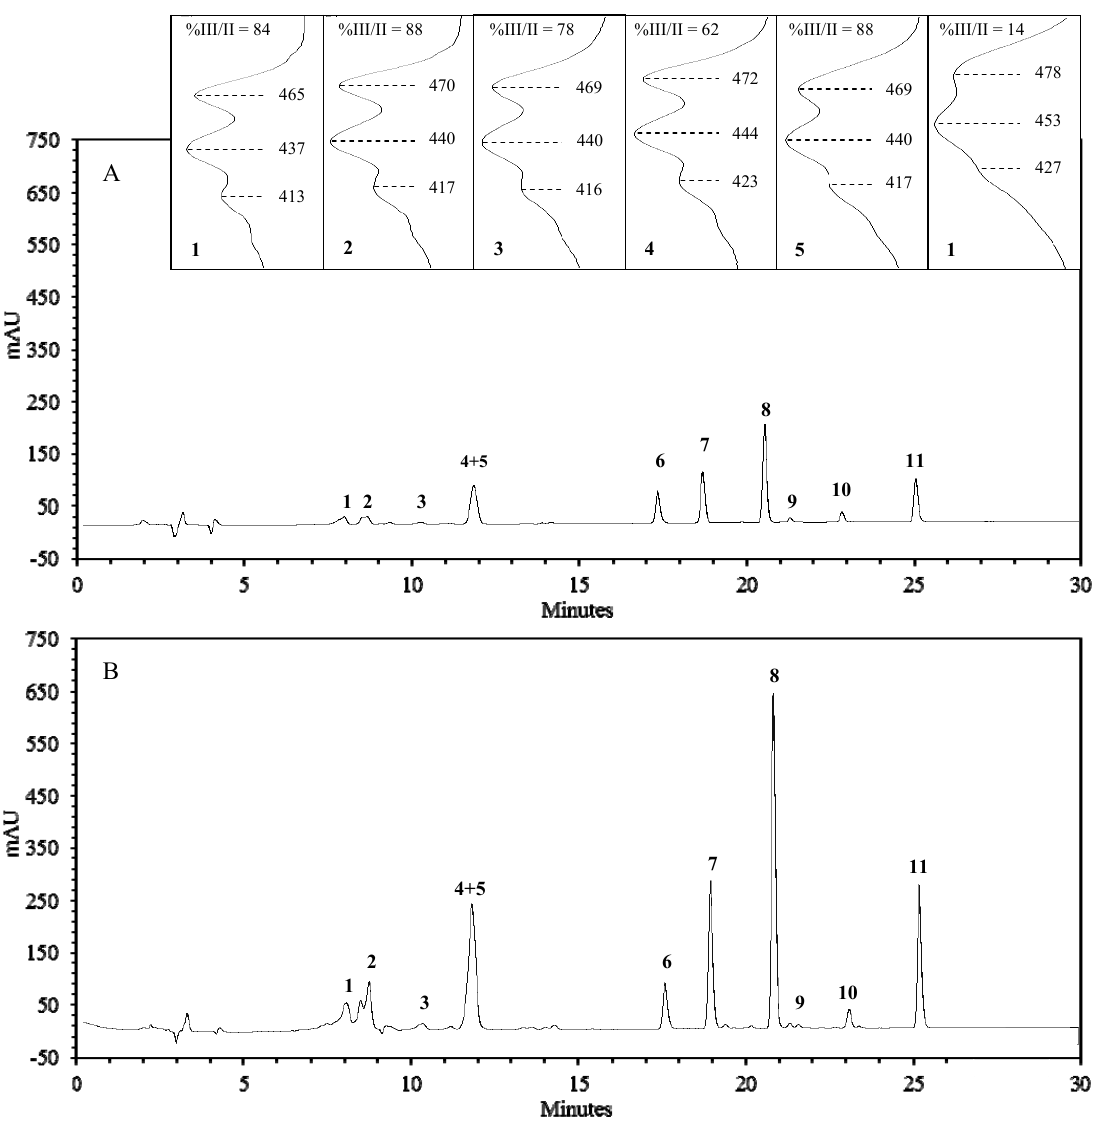
Figure 1. Representative chromatograms of lettuce extracts from a control group ( A ) and a 15% SCG group ( B ), recorded at 440 nm. ( 1 ) Neoxanthin; ( 2 ) Violaxanthin; ( 3 )